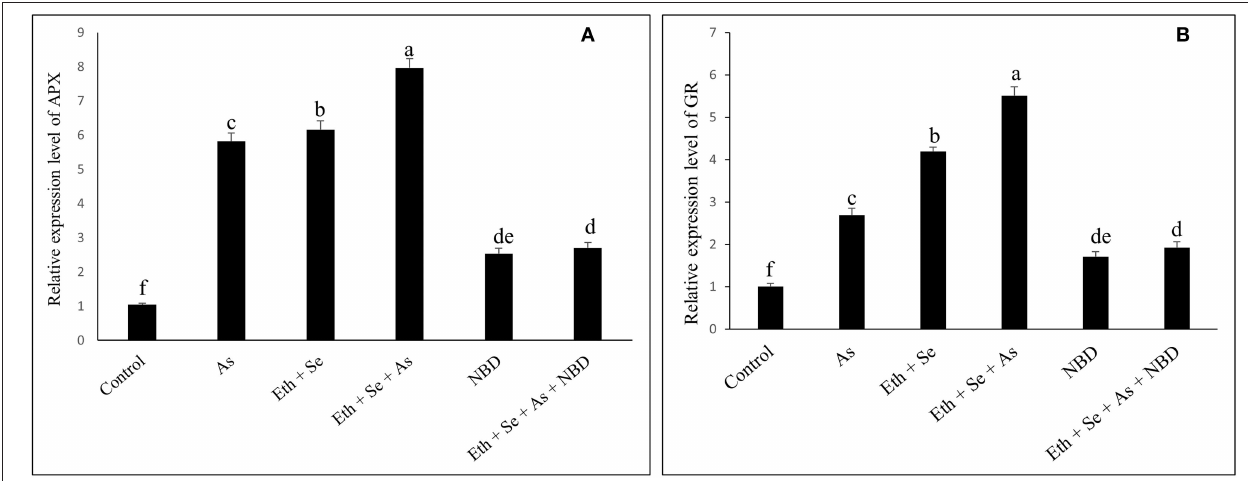
FIGURE 5 | Relative expression level of genes encoding APX (A) and GR (B) enzymes in mustard ( B. juncea L.) leaves grown with 200 µ l L − 1 Eth and/or 2-mg Se kg − 1 soil in the presence or absence of 24-mg As kg − 1 soil at 30 DAS. The treatment with 100 µ M NBD was applied either alone or with combination of 200 µ l L − 1 Eth and 2-mg kg − 1 soil Se with 24-mg As kg − 1 soil. Results are represented relative to the respective control (control, 1). Data are represented as means ± SE ( n = 4). Data followed by same letter are not significantly different by LSD test at p < 0.05. As, arsenic; Eth, ethephon; Se, selenium.